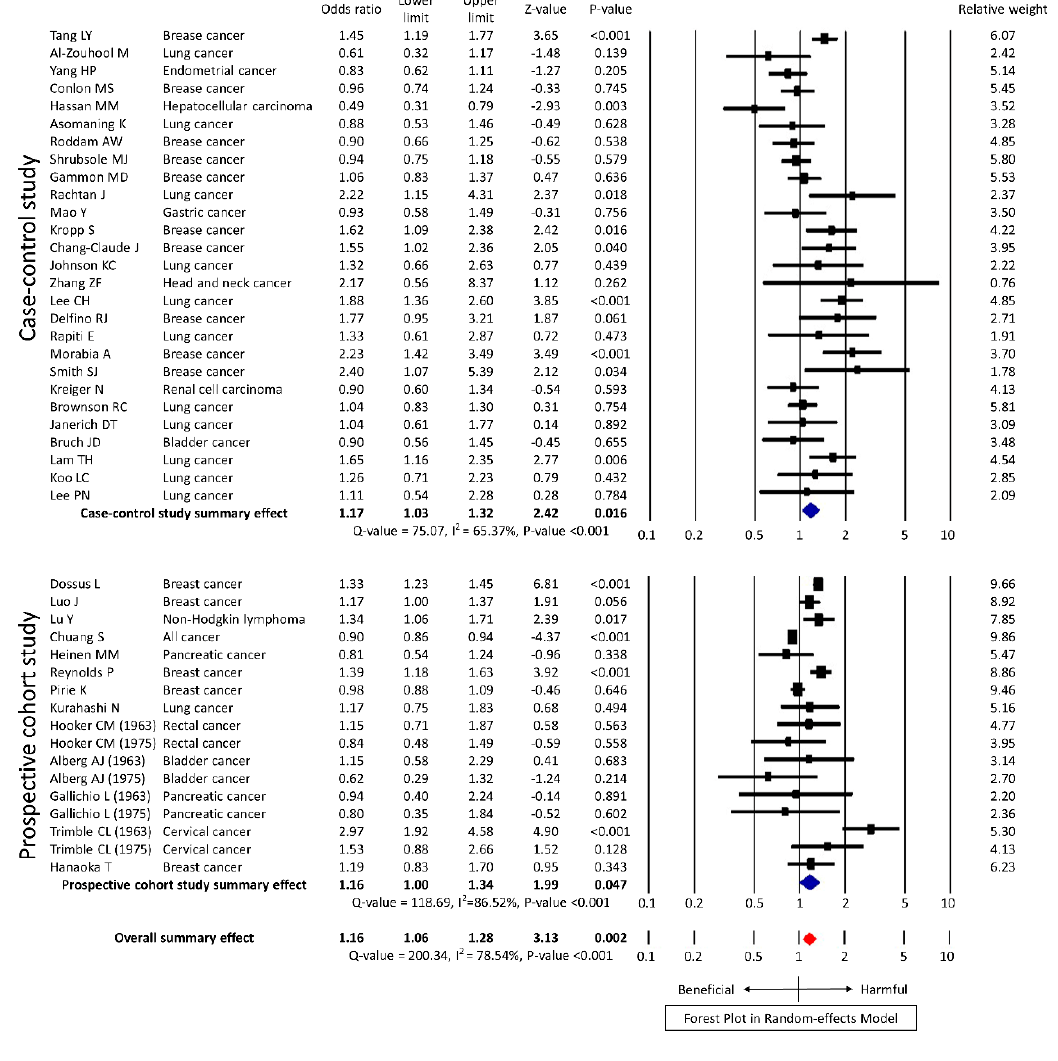
Figure 2. Forest plot on the association of secondhand smoke and cancer risk with unadjusted data in random-effects model.